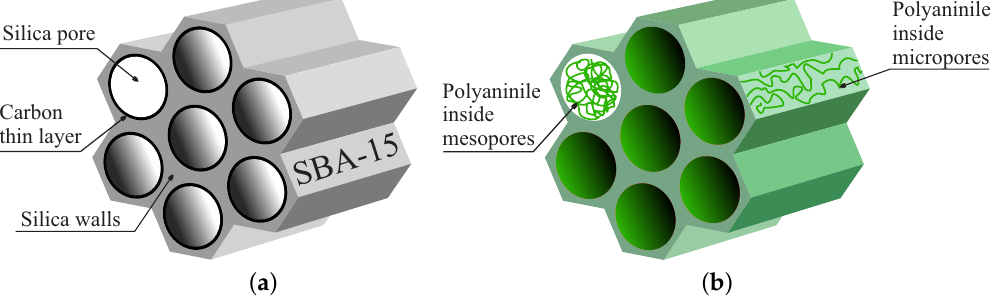
Figure 3. A schematic representation of the porous silica-based composite materials for the application of supercapacitors: ( a ) a carbon-lined SBA-15 mesoporous silica; and ( b ) SBA-15 containing polyaniline chains inside its